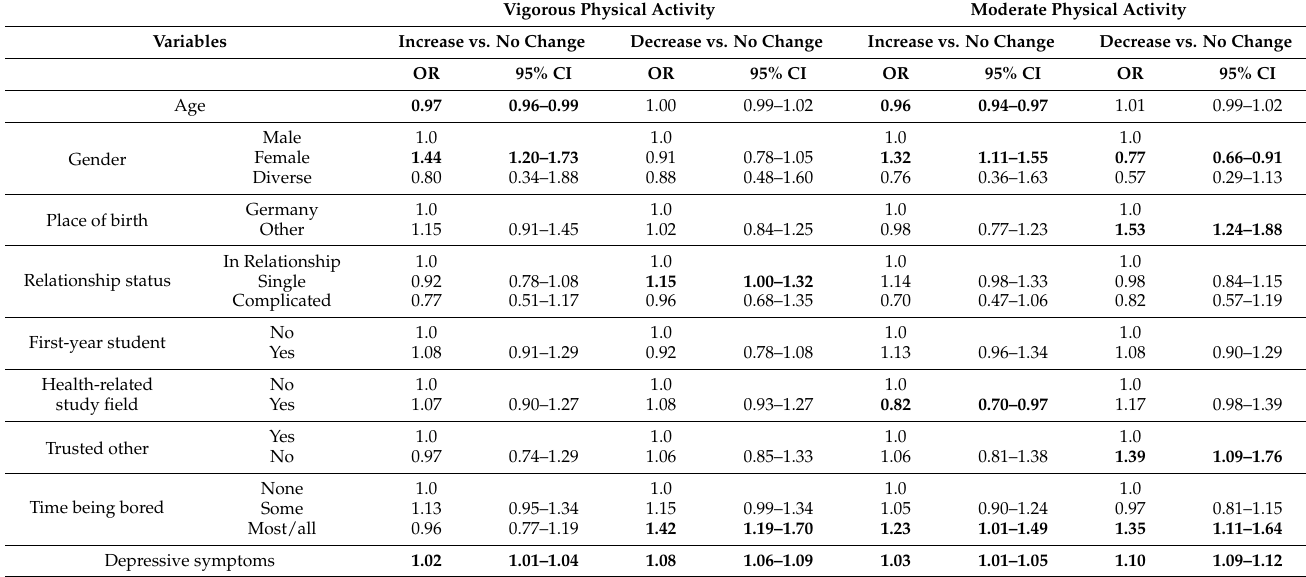
Table 5. Associations between change in physical activity and age, gender, place of birth, relationship status, being a first-year student, study field, trusted other, boredom, as well as depressive symptoms—Results of multinomial logistic regressions (ORs and 95%